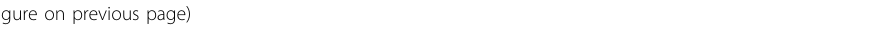
Fig. 4 Aging-related G-MDSCs suppress fi broblast senescence and apoptosis. A , B Young fi broblasts were cultured with aging-related G-MDSCs for 24 h to determine the changes induced by aging-related G-MDSCs. A Immuno fl uorescence results revealed the level of OPN in fi broblasts. Scale bars, 50 μ m. B The levels of β -galactosidase in fi broblasts analyzed by fl ow cytometry through C12FDG staining. Representative cytograms are shown on the top, and statistical data are shown on the bottom; n = 7 per group. C – F The senescent fi broblast model was induced by UV treatment. Then, we investigated the in fl uence of G-MDSCs on fi broblast senescence and apoptosis. C Representative images of senescent fi broblasts detected by X- gal staining are shown on the top, and statistical data are shown on the bottom. Red arrows represent X-Gal + fi broblasts; n = 8 per group. Scale bars, 50 μ m. D Cell cycle distribution and the percentage of fi broblasts in S phase were detected by fl ow cytometry. Representative cytograms are shown on the top, and statistical data are shown on the bottom; n = 8 per group. E The mRNA levels of the senescence markers Cdkn2a and Cdkn2b in the fi broblasts with or without UV treatment analyzed by qPCR; n = 8 per group. F The percentage of apoptotic fi broblasts was detected by fl ow cytometry using Annexin V-FITC and PI staining. Representative cytograms are shown on the top, and statistical data are shown on the bottom; n = 8 per group. The data are presented as the means ± SDs. Differences were determined by an unpaired t test, one-way ANOVA (more than 2 groups) or two-way ANOVA (more than 2 factors), and Tukey ’ s HSD post hoc test (for one-way ANOVA) or a Sidak HSD post hoc test (for two-way ANOVA) was performed. * P <